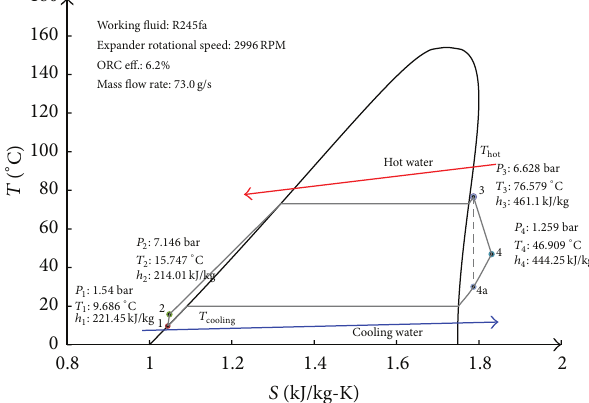
Figure 17: Schematic T - S diagram of the low-temperature Rankine cycle